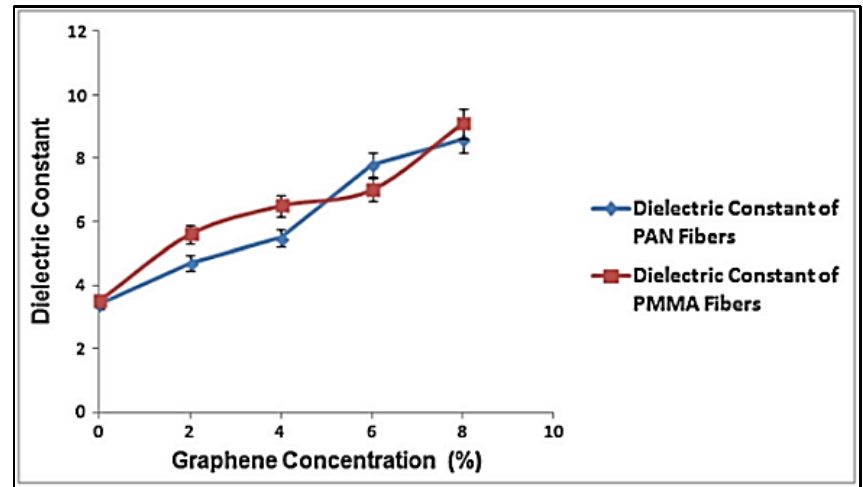
Figure 16. Dielectric constant of PAN at 8 wt.% in the radio frequency range [2] .